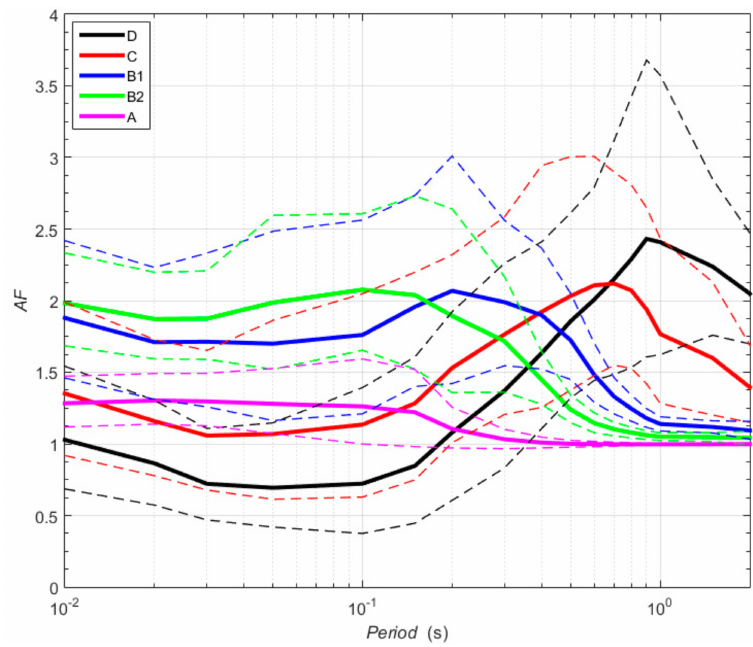
Figure 9. Median site amplification factors [41] for V S 30 site classes based on Eurocode 8 with ( ± 1 standard deviation (dashed lines) for the PGA ROCK in the range of 0.159–0.185 g